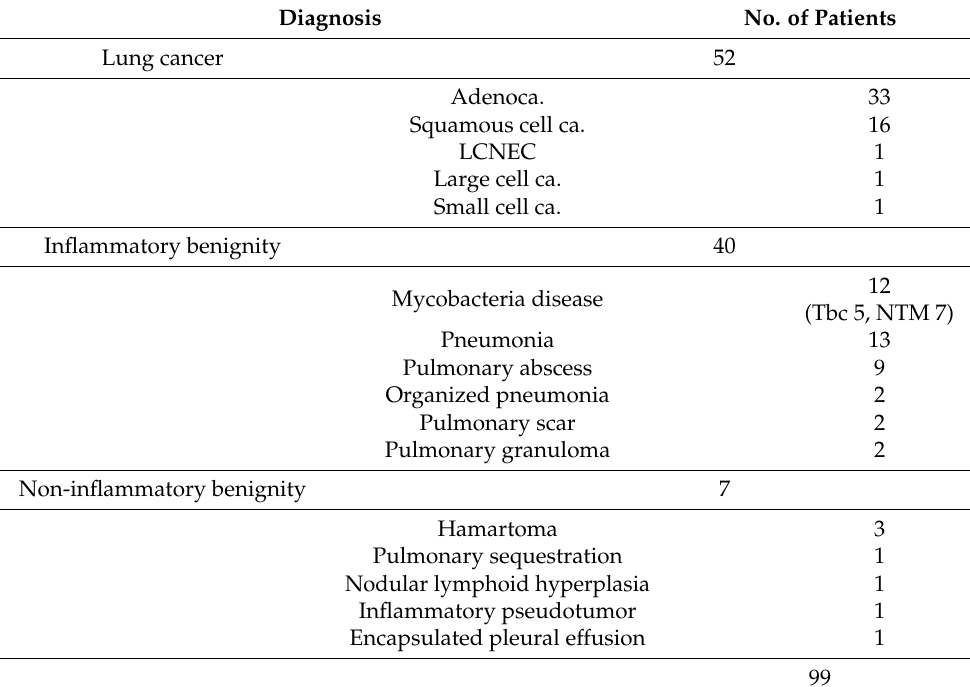
Table 1. Patient